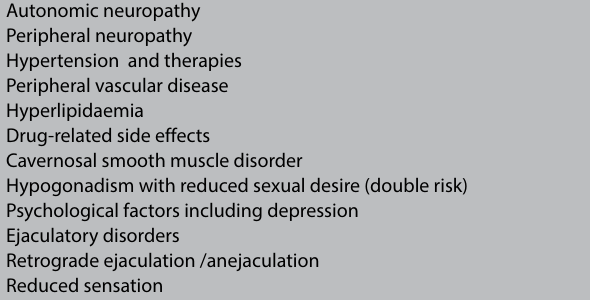
Table I: Mechanisms associated with ED in type 2 diabetes 9 Autonomic neuropathy Peripheral neuropathy Hypertension and therapies Peripheral vascular disease Hyperlipidaemia Drug-related side